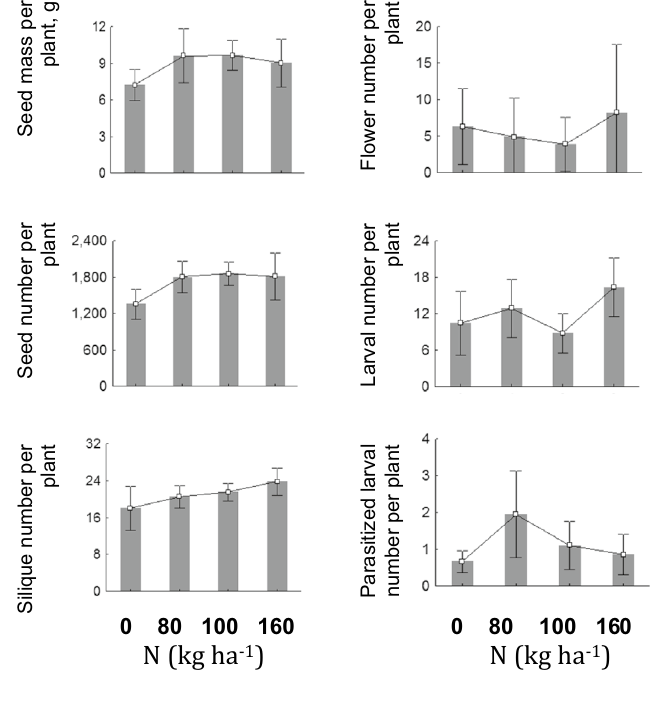
Figure 1. Brassica napus yield and the numbers of flowers (on harvesting day of HS experiment, end of July 2014), beetle larvae and parasitized larvae in dependence on the fertilization rate (means ± 95%